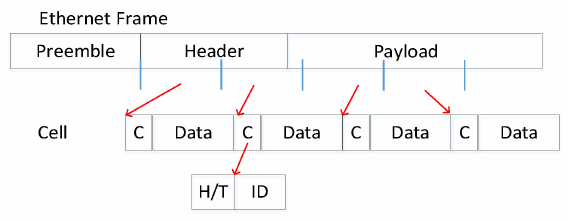
Figure 5. The relationship between Cells and Ethernet frame.